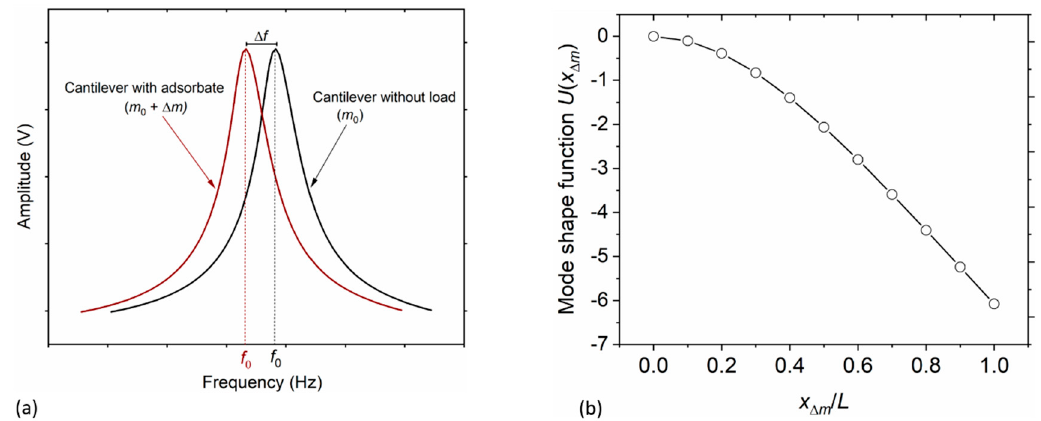
Figure 11. ( a ) Schematic representation of the shift Δ f in resonant frequency of a cantilever with/without an adsorbate (load, Δ m ). ( b ) Mode shape function (calculated based on Equation (3)) at a point x Δ m / L along the cantilever beam of length L vibrating in the first (fundamental) mode of which λ≈ 1.8751. In our experimental work, typical particle adsorption positions ranged from x Δ 0.8.